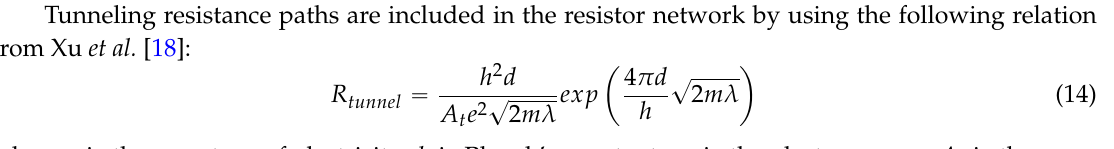
Figure 11. Tunneling path between two nodes.